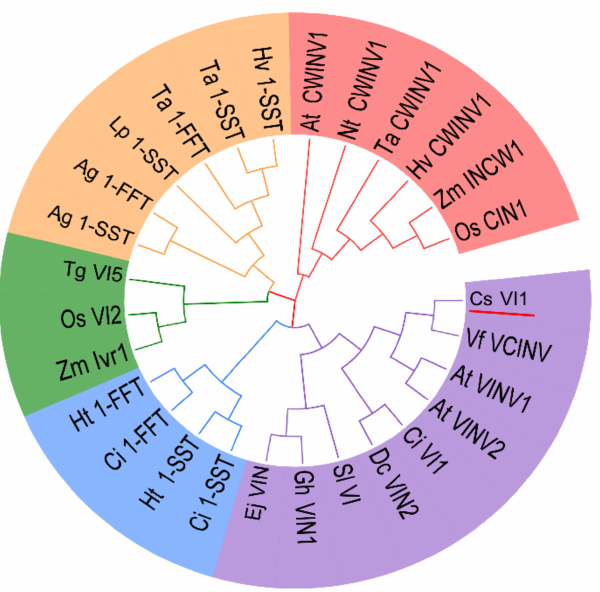
Figure 6. Phylogenetic analysis of cDNA-derived amino acid sequences of vacuolar invertase and vacuolar invertase-like predicted proteins from cucumber and other plant species. Five groups can be distinguished. Groups shown in green and purple are classified as vacuolar invertase (VIs). The VIs from monocot species are shown in green, while those from dicot species are shown in purple. The cell wall invertase group is shown in red. Groups shown in yellow and blue are classified as fructan biosynthetic enzymes (FBEs). CsVI1 is underlined. Plant species are abbreviated as follows: At, Arabidopsis thaliana ; Ag, Agave tequilana ; Ci, Cichorium intybus ; Cs, Cucumis sativus ; Dc, Daucus carota ; Ej, Eriobotrya japonica ; Gh, Gossypium hirsutum ; Ht, Helianthus tuberosus ; Nt, Nicotiana tabacum ; Hv, Hordeum vulgare ; Lp, Lolium perenne ; Os, Oryza sativa ; Sl, Solanum lycopersicum ; Ta, Triticum aestivum ; Tg, Tulipa gesneriana ; Vf, Vicia faba ; and Zm, Zea mays. Phylogenetic and molecular evolutionary analyses were conducted using MEGA7 (https://www.megasoftware.net/, accessed on 7 January 2019) by neighbor-joining analysis